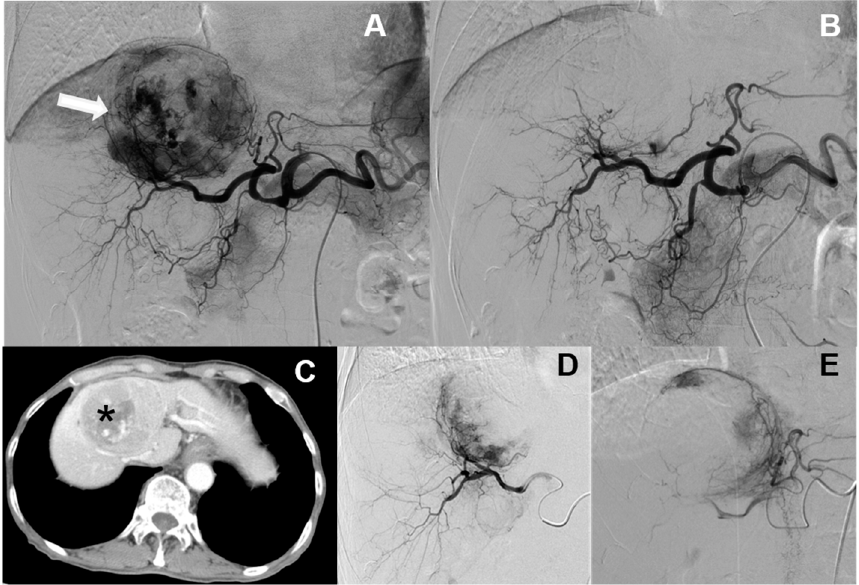
Figure 2. Microsphere embolization (DC bead TACE). A 7.3 cm hepatocellular carcinoma (HCC) with arterial enhancement in segment 4 and 8 of the liver in both angiography ( A , white arrows) and CT ( C , * star) images. TACE is performed by using drug eluting microspheres ( D and E ). Follow-up angiography shows complete embolization of the tumor ( B ).